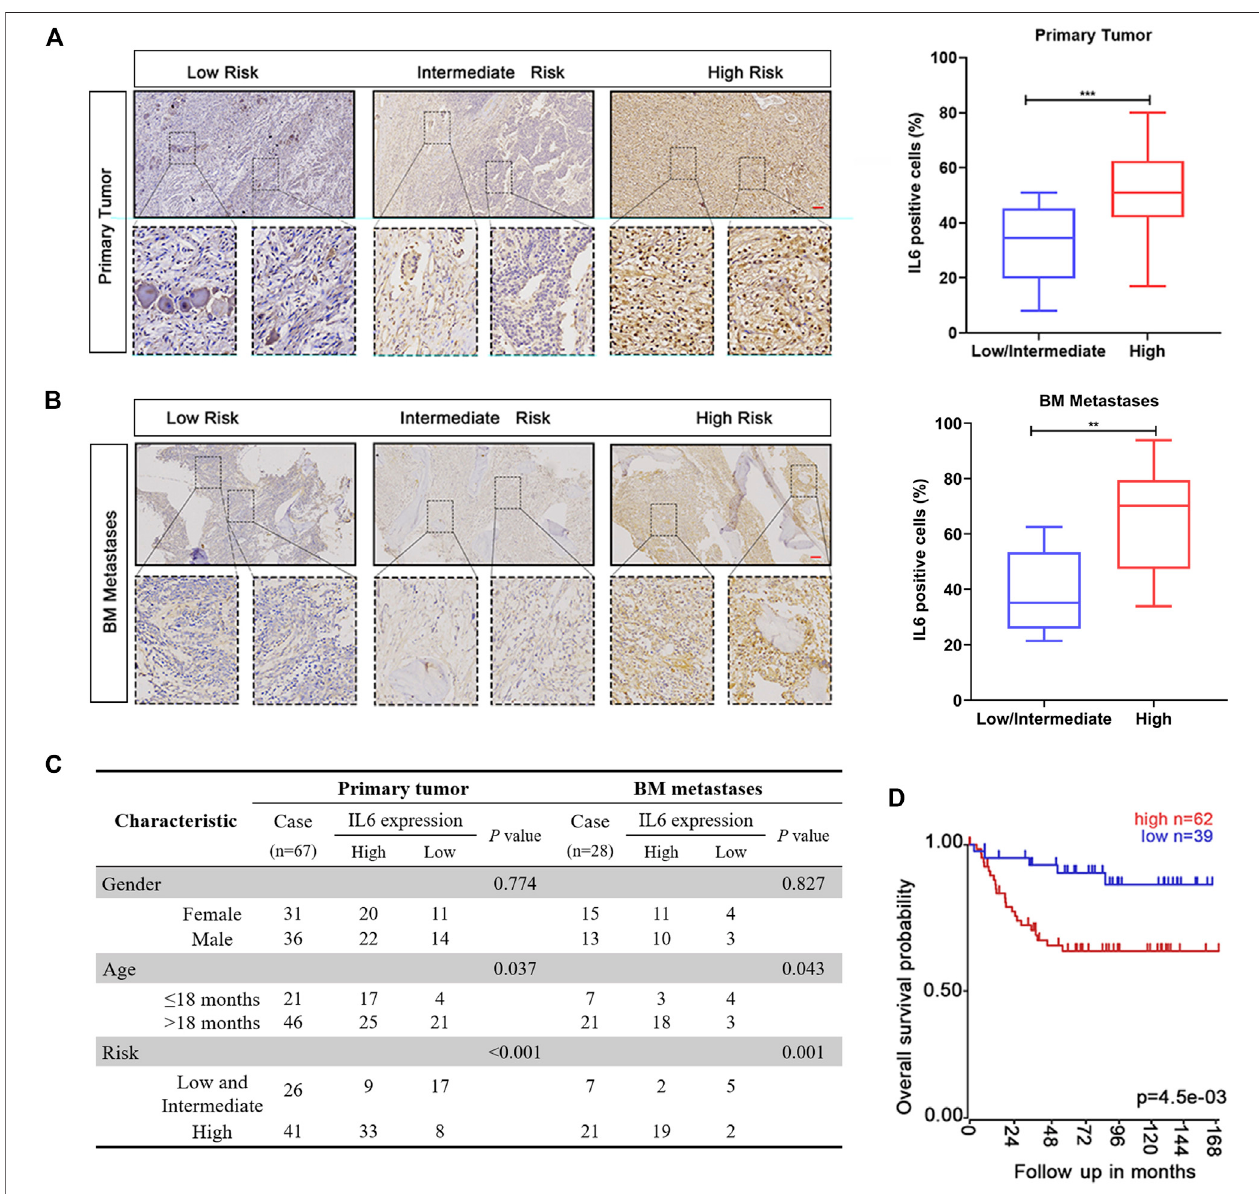
FIGURE1| TheexpressionofIL6isrelatedtotheclinicalfactorsandprognosisofNBpatients. (A,B) IHCstainingofIL6wasdetectedinNBprimarytissuesandBM metastases.Scalebars,100 μ m ***p < 0.001comparedwithLow/intermediateriskpatients. (C) TheproteinexpressionofIL6inNBprimarytissuesandBMmetastases. (D) Correlation between patients ’ clinical characteristics and IL6 protein expression. p values were calculated using Pearson ’ s χ 2 test and Fisher ’ s exact test.